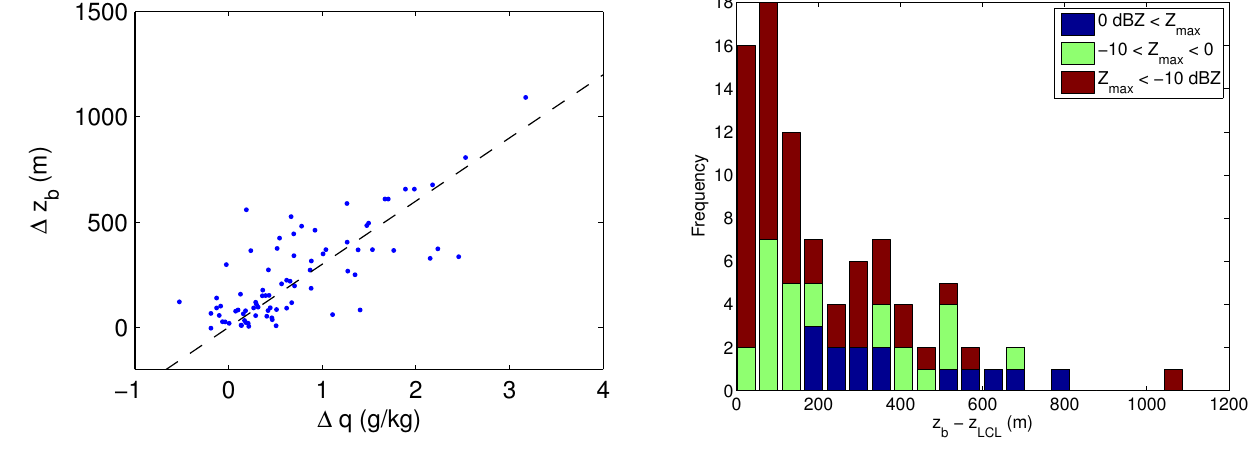
Fig. 7. Mean cloud base – LCL ( 1z b ) for each subcloud leg. Each bin is also separated based on